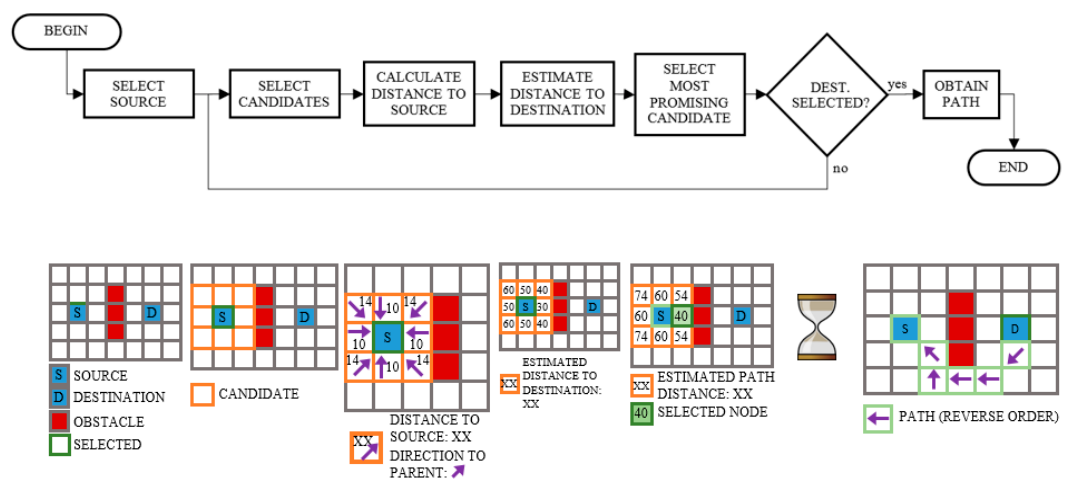
Figure 4. A* workflow.